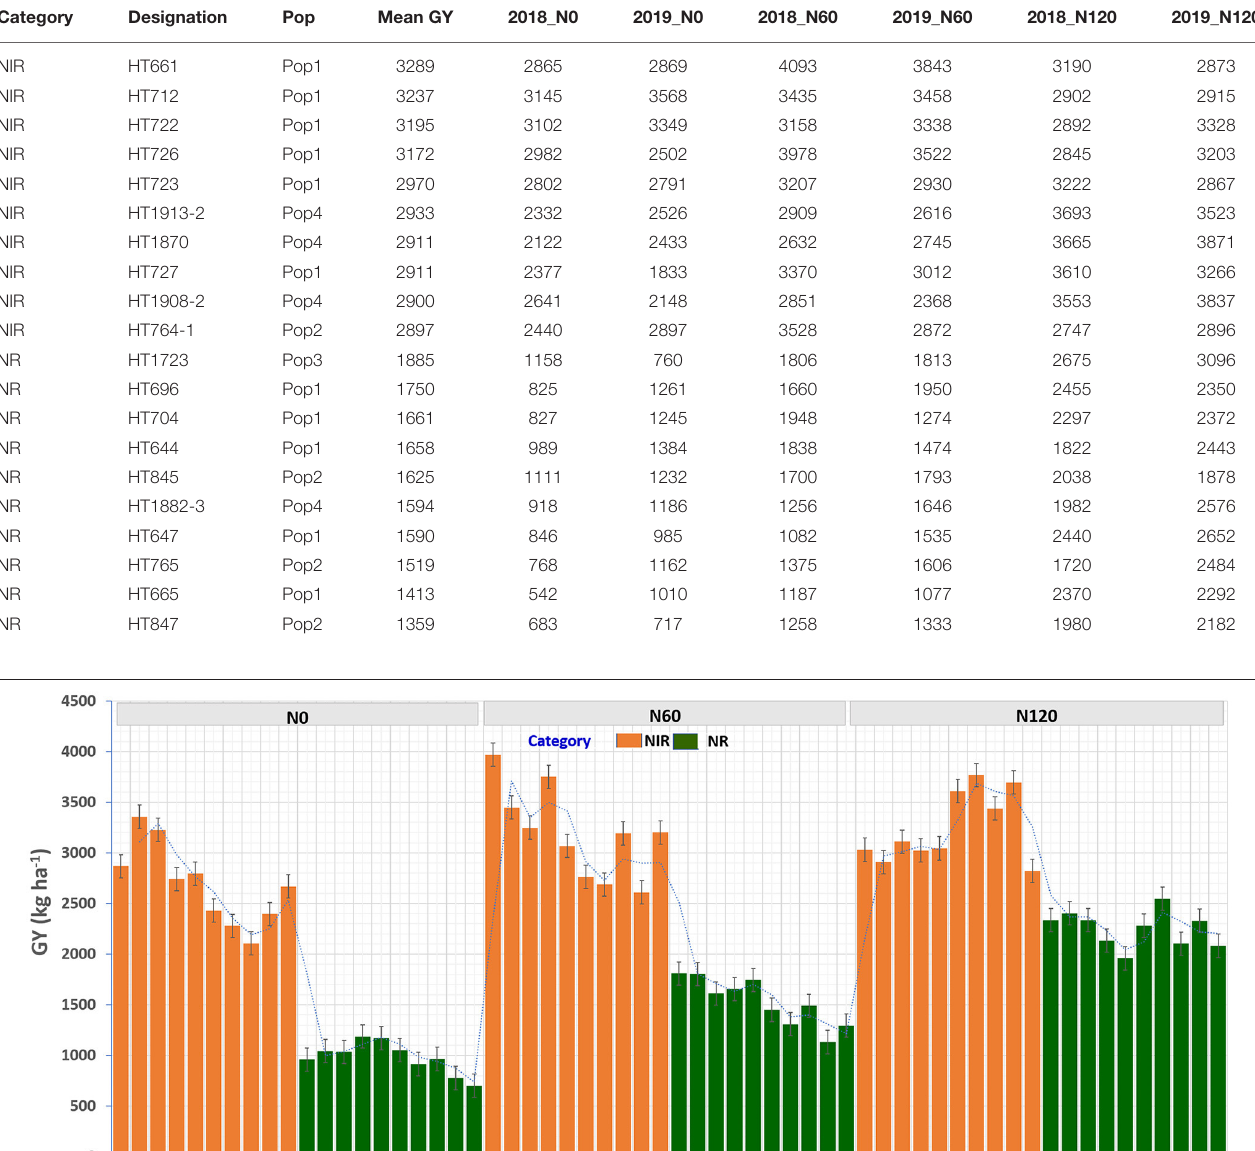
TABLE 4 | The top 10 nitrogen irresponsive (NIR) and 10 nitrogen responsive (NR) breeding lines with contrasting grain yield (GY; kg ha − 1 ) derived from pooled mean over two seasons and three treatments.